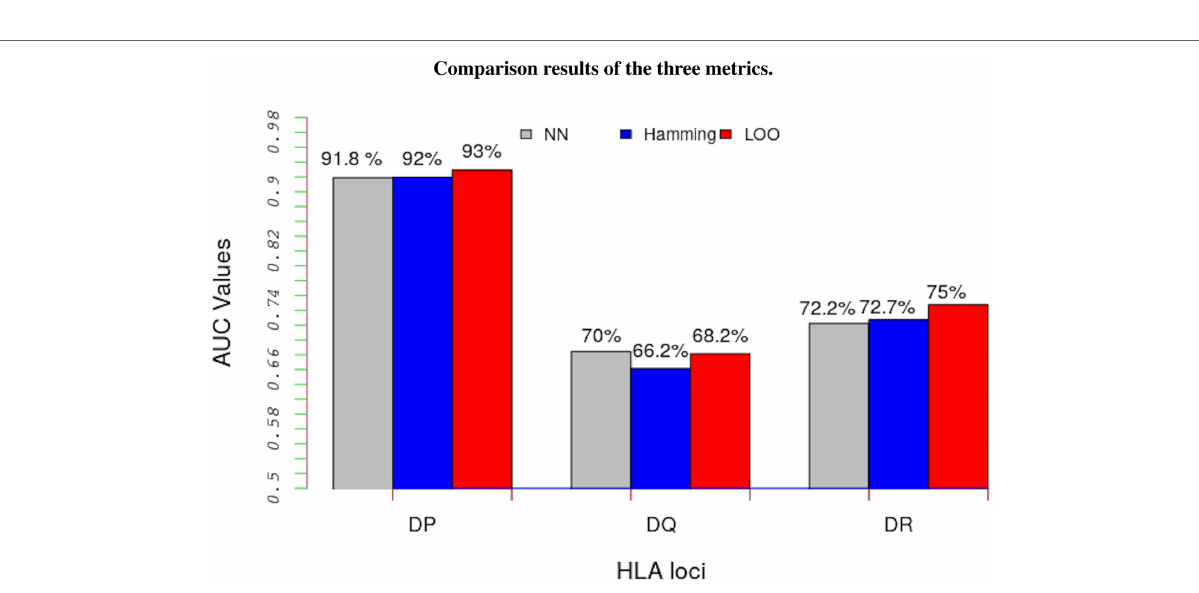
Frontiers in Immunology |